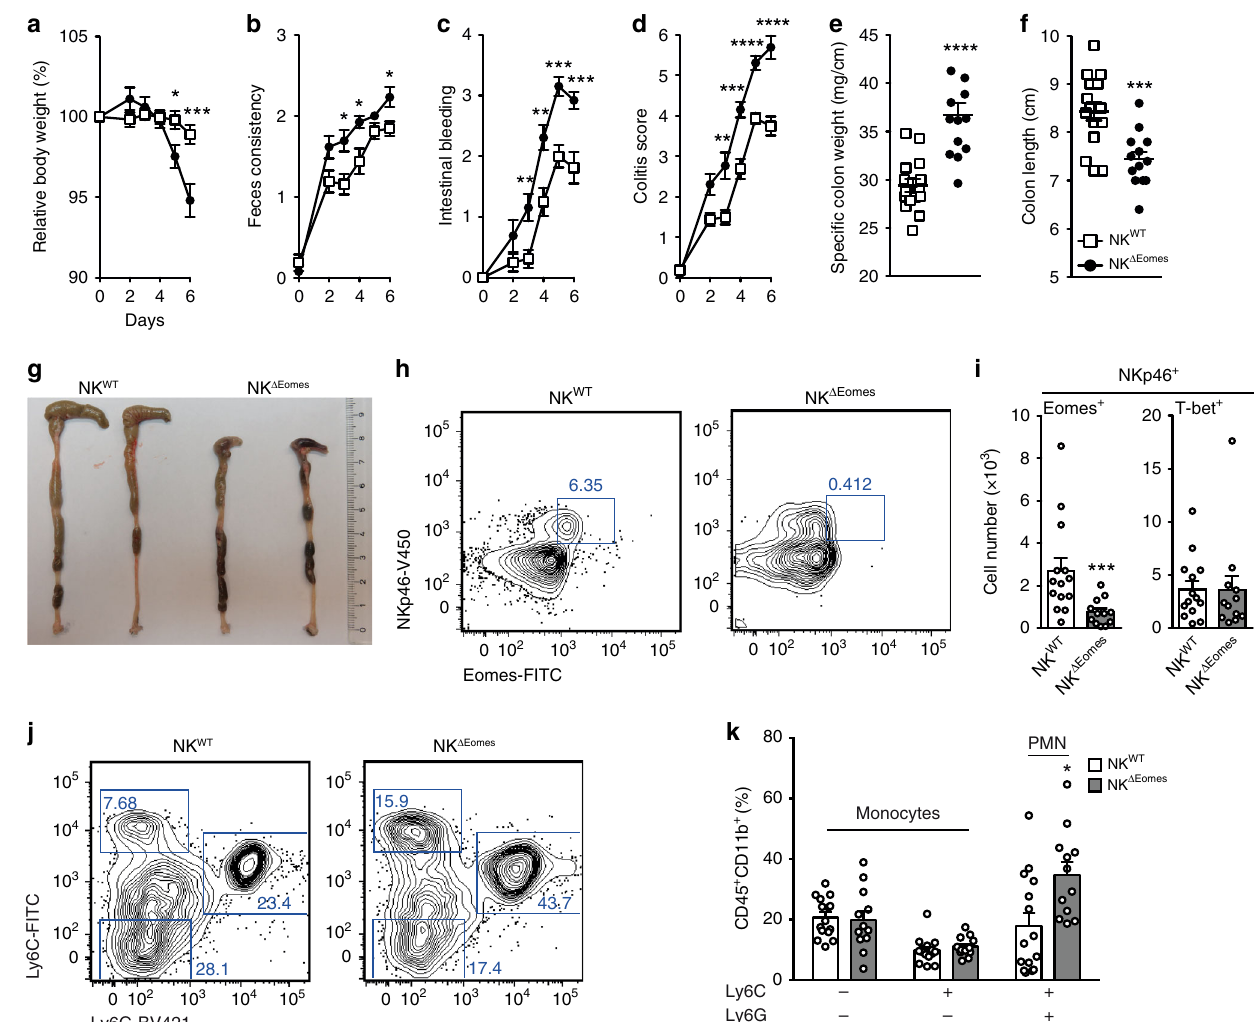
Fig. 8 Conventional NK cells ameliorate acute colitis. a – k NK WT and NK Δ Eomes mice were treated with DSS for 5 days as described in Fig. 4. a Relative body weight, b feces consistency, and c the degree of intestinal bleeding were measured on a daily basis to calculate d the overall colitis score. e – g At day 7, e the speci fi c weight and f , g the length of the colon were determined. g Shown are representative photographs of colon and cecum (scale unit = cm). h , i Colonic lamina propria leukocytes were analyzed by fl ow cytometry at day 7. Frequencies of Lin − CD45 + NKp46 + ILC1 (T-bet + ) and cNK (Eomes + ) and j , k CD45 + CD11b + Ly6C + / − Ly6G − monocyctes as well as Ly6C + Ly6G + neutrophils (PMN) were determined by fl ow cytometry. i Absolute cell numbers were calculated. h , j Representative contour plots are shown. Numbers indicate percentages. a – f , i and k Data were pooled from two independent experiments with a total of 12 – 16 mice per group. Data show means + /± SEM. Source data are provided as source data fi le; * p ≤ 0.05; ** p ≤